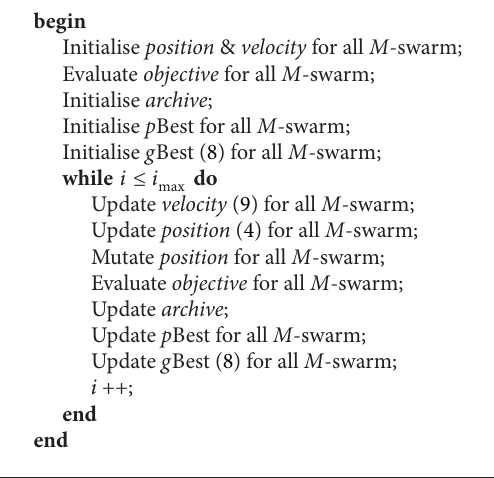
Algorithm 3: The VEPSO algorithm using multinondominated